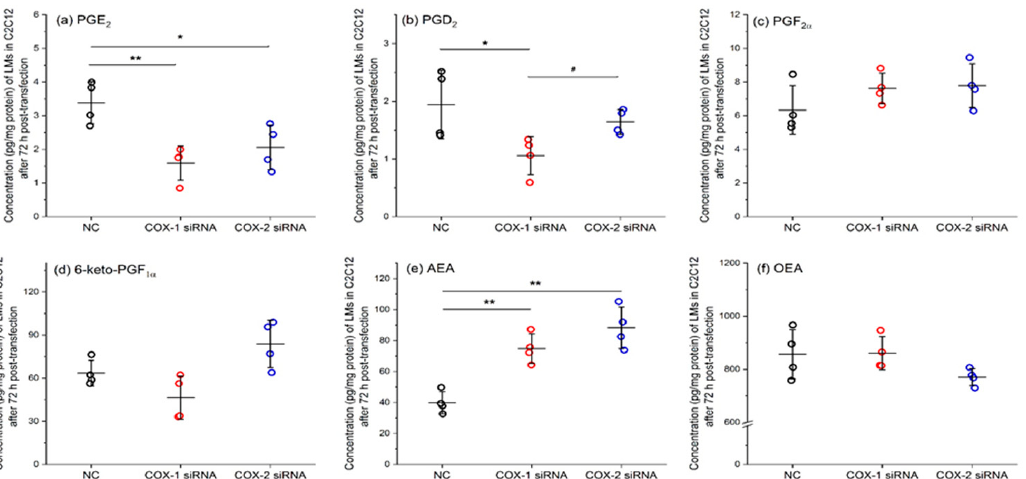
Figure 6. COX-1 or -2 knockdown alters the levels of key lipid mediators in C2C12 muscle cells. n = 4, * p < 0.05 and ** p < 0.01 compared with NC; # p < 0.05 compared with COX-1 siRNA.